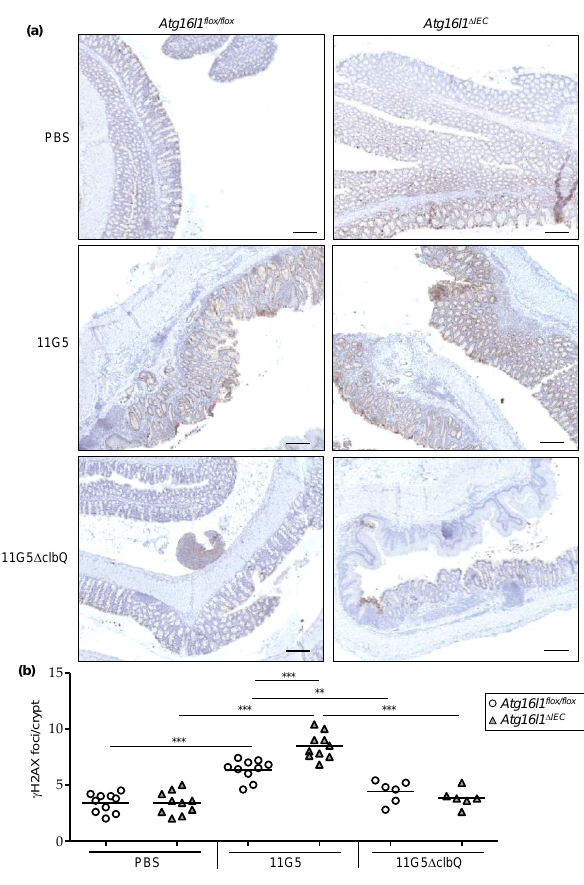
Figure 5. CoPEC infection increases marker of DNA damage in colonic crypt in a mouse model of chronic DSS treatment, and this was further enhanced by autophagy deficiency in IECs. Atg16l1 flox/flox and Atg16l1 ∆IEC mice were treated with streptomycin for 3 days and then received water for 24 h before being orally administered (day 0) with PBS or with 10 9 colony-forming units of 11G5 bacteria or the mutant 11G5∆clbQ. ( a ) Immunohistochemical staining for γH2AX in mouse colonic sections. Bars = 200 µm. ( b ) Quantification of γH2AX foci number per crypt determined from 20 crypts/mouse, N = 10 mice/group for +PBS or 11G5-infected mice, N = 6 mice/group for 11G5∆clbQ-infected mice. Each symbol represents data from one mouse, lines at mean. ** p ≤ 0.01; *** p ≤ 0.001 by one-way ANOVA, followed by a post-test Bonferroni.